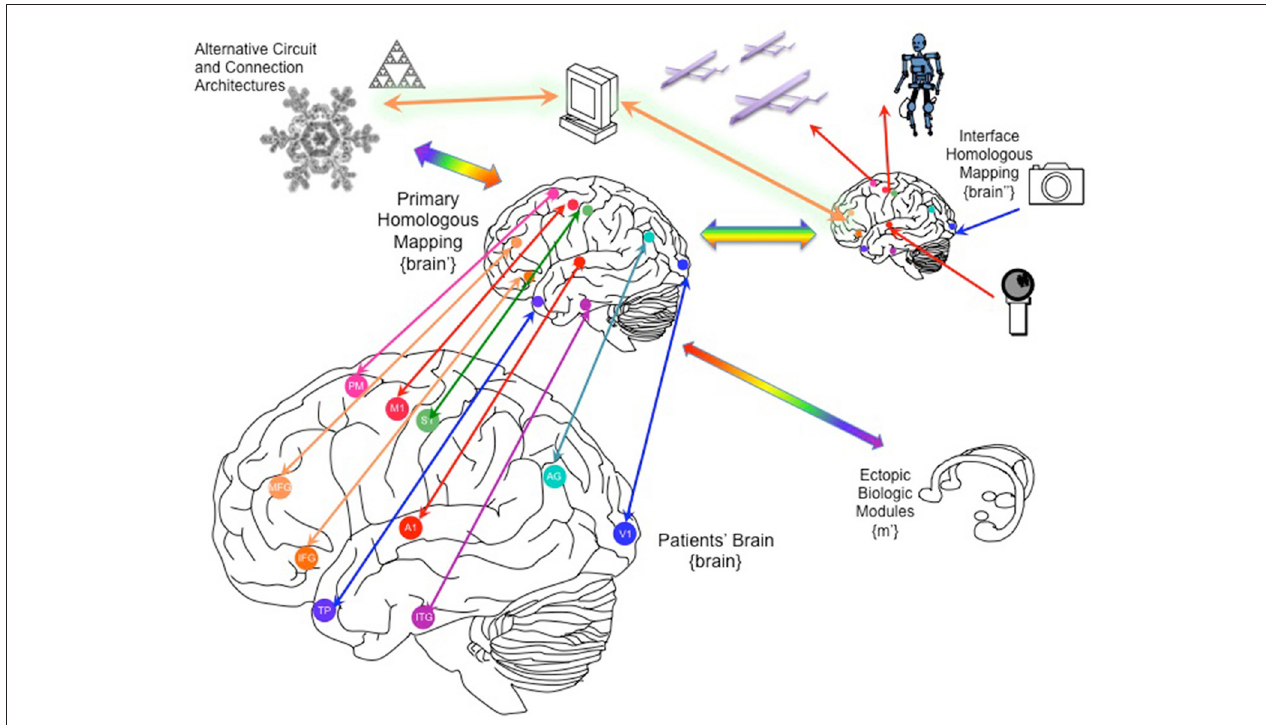
FIGURE 5 | Linking the brain to one or more whole-brain emulations. Through recording/stimulation devices implanted into key primary, heteromodal and higher order cortical targets, the patient’s brain can be linked to homologous counterparts in a parallel whole brain emulation that can function as an auxiliary, parallel system. This “primary homologous emulation” can also function as an intermediary to secondary emulations, such as an “interface homologous mapping” explicitly designed to link to its own artificial sensors and effectors, and to ectopic biological modules, including organoids that could be implanted into the patient’s peritoneum. In addition to brain-inspired architectures, the primary homologous mapping could be linked to novel artificial architectures derived from other natural organization principles. MFG, middle frotal gyrus; IFG, inferior frontal gyrus; TP, temporal pole, A1, primary auditory cortex, V1, primary visual cortex, S1, primary sensory cortex, M1, primary motor cortex, AG, angular gyrus, PM, premotor